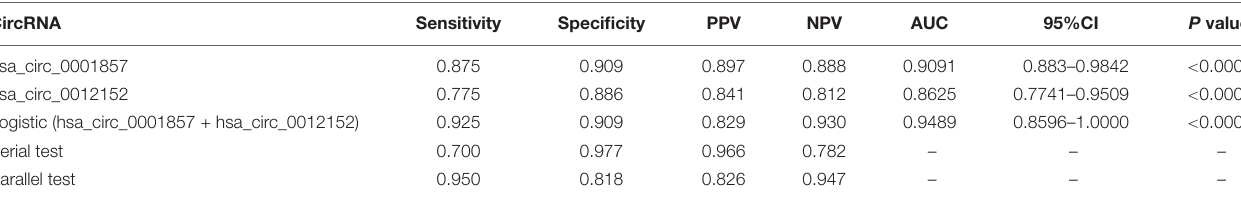
TABLE 2 | Diagnostic efficiency of hsa_circ_0012512 and hsa_circ_0001857 as classification biomarkers to discriminate acute lymphoblastic leukemia (ALL) from acute myeloid leukemia (AML). CircRNA